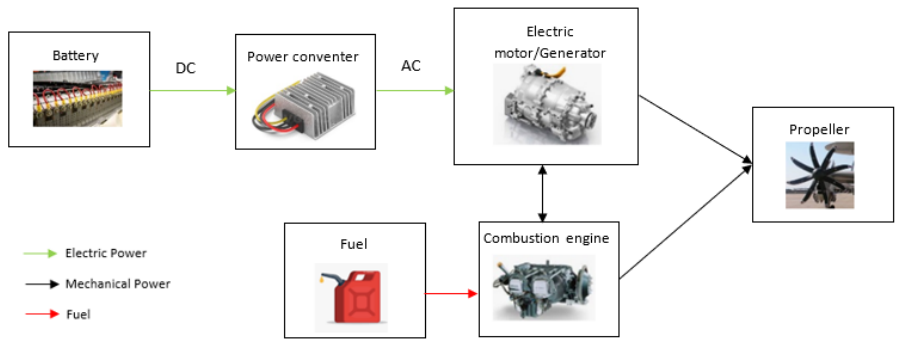
Figure 3. Series-parallel architecture. Source: Processed by authors.